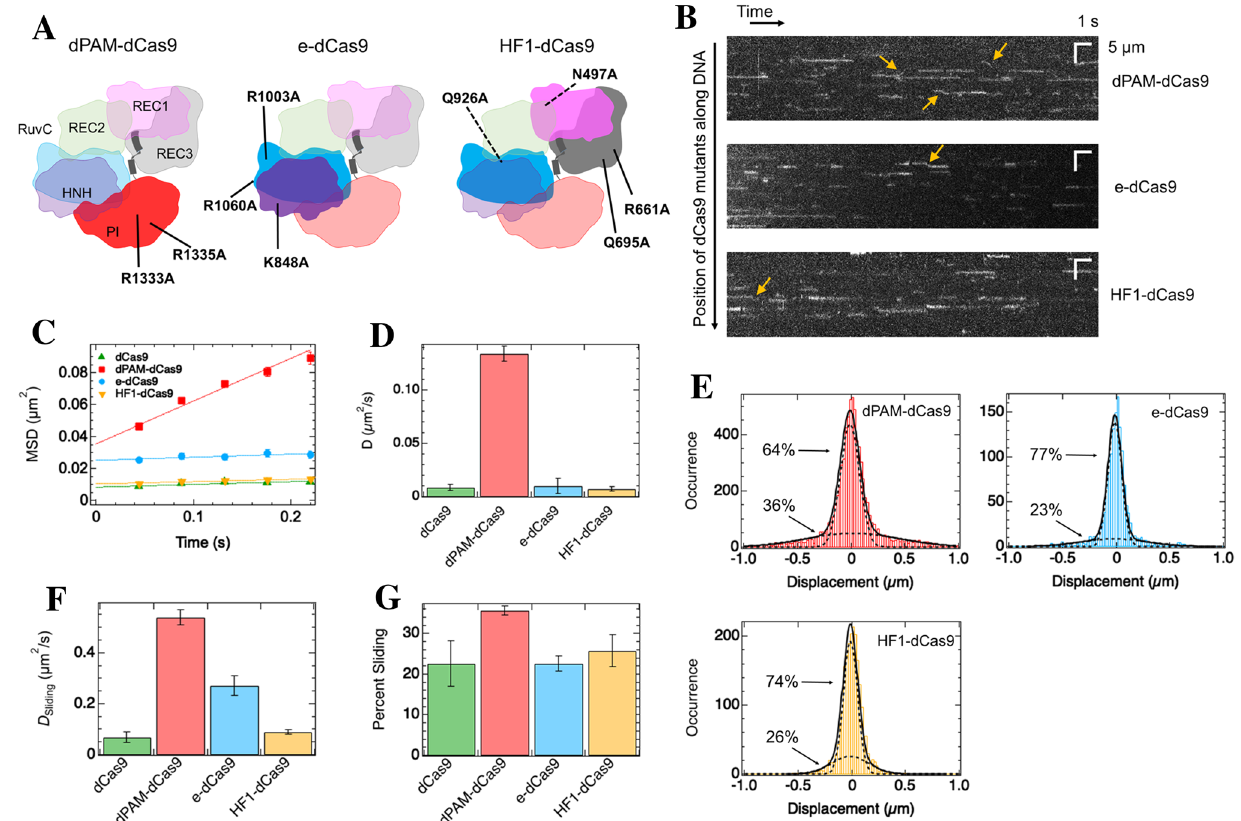
Figure 2. PAM-recognizing residues stabilize the sliding mode and cause high friction for the sliding in the absence of sgRNA. (A) Schematic diagram of mutation sites in 3D structures of dCas9 mutants. dCas9 is composed of the REC1, REC2, REC3, RuvC, HNH, and PI domains. The domains with mutation sites are displayed densely. (B) Typical kymographs of dCas9 mutants. White lines or curves denote traces of single molecules. Yellow arrows represent sliding molecules. (C) MSD plots of all tracked molecules of dCas9 and its mutants ( N = 232 for dCas9, 1754 for dPAM-dCas9, 255 for e-dCas9, and 448 for HF1-dCas9). The errors denote standard errors. Best-fit linear lines are shown ( R 2 = 0.80 for dCas9, 0.88 for dPAM-dCas9, 0.72 for e-dCas9, and 0.92 for HF1-dCas9). (D) Average diffusion coefficient of dCas9 and its mutants along DNA. (E) Displacement distribution of dCas9 mutants at a time interval of 176 ms. Black curves represent the best-fit curves based on the sum of two Gaussian functions. The dashed curves represent the distributions of each mode. (F) Diffusion coefficient of sliding mode of dCas9 and its mutants. (G) Sliding mode percentage of dCas9 and its mutants. The errors denote fitting errors in panels D, F, and